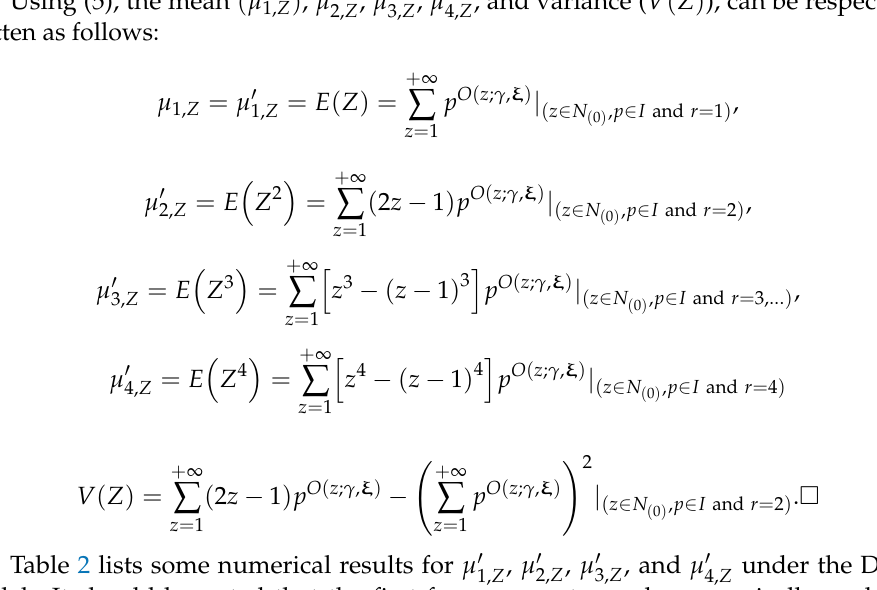
Table 2 lists some numerical results for µ (cid:48)